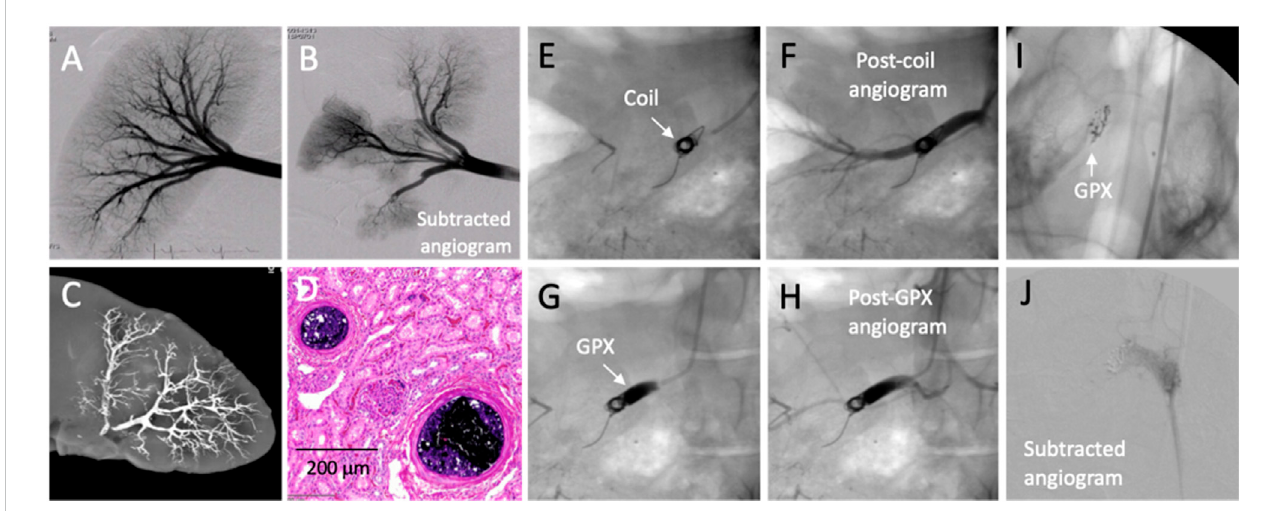
FIGURE 5 In vivo testing of GPX in acute swine models. (A) Pre-embolization angiogram. (B) Post-embolization subtracted angiogram after GPX400-Ta30 was sequentially injected into two separate renal artery sub-branches. (C) X-ray image of explanted embolized kidney. (D) Acute H&E stained histological section showing occluded arterioles. (E) Platinum coil in renal artery. (F) Post-coil angiogram. (G) GPX500-Ta30 deployed proximal to coil. (H) Post-GPX angiogram showed complete occlusion. (I) GPX350-Ta30 injected into right swine rete mirabile. (J) Post-embolization